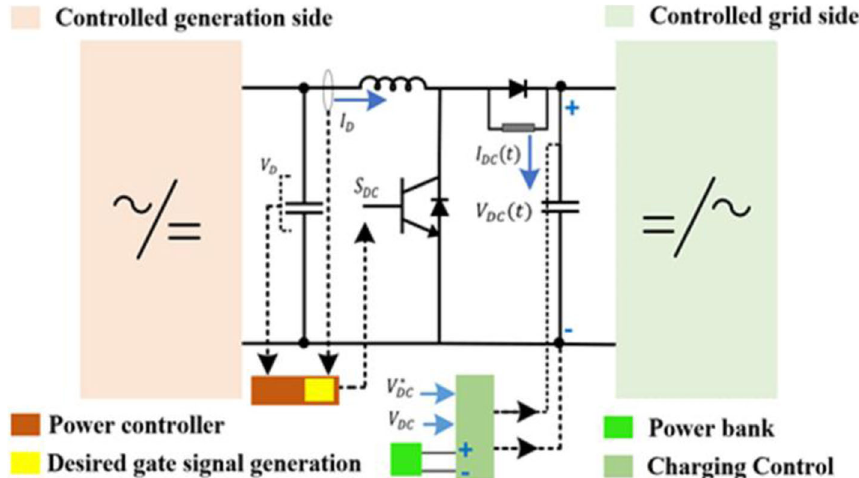
Fig. 7 Scheme of DC-link